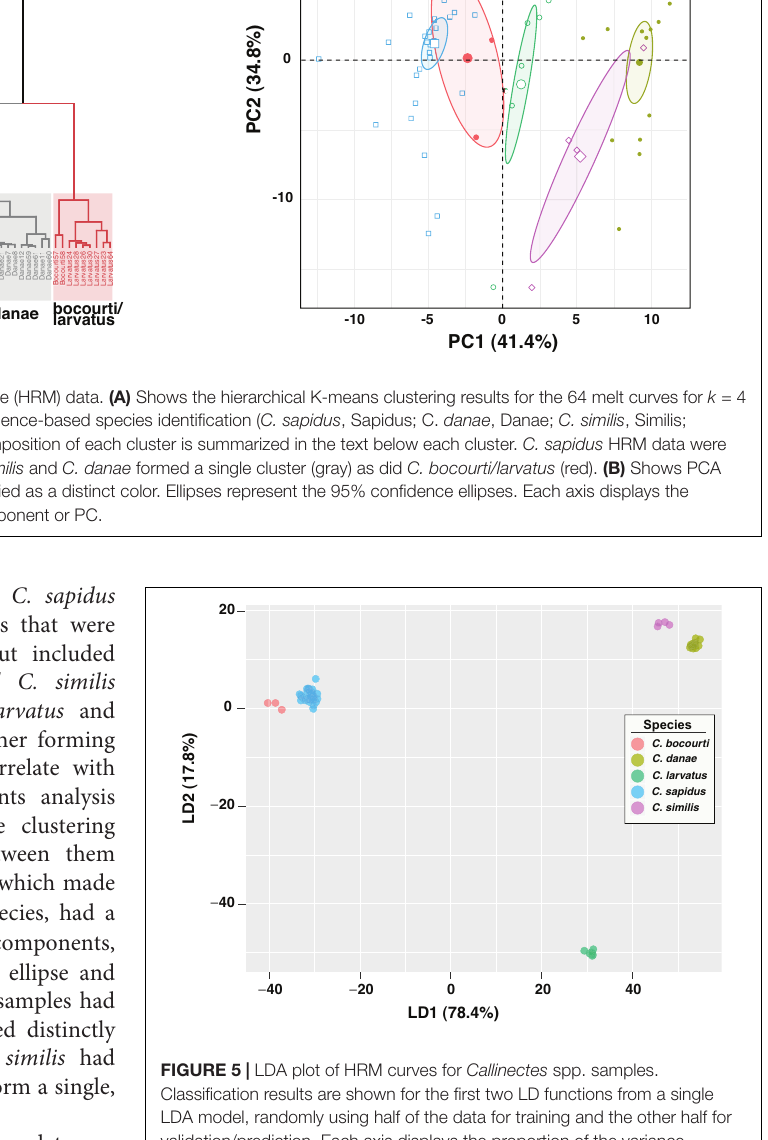
89.6% for C. danae and C. similis references and 88.4% for C. bocourti and C. larvatus references ( Figure 6 ). Variance in the mean assignment success across training/validation sets appeared to be highest for the C. larvatus reference.